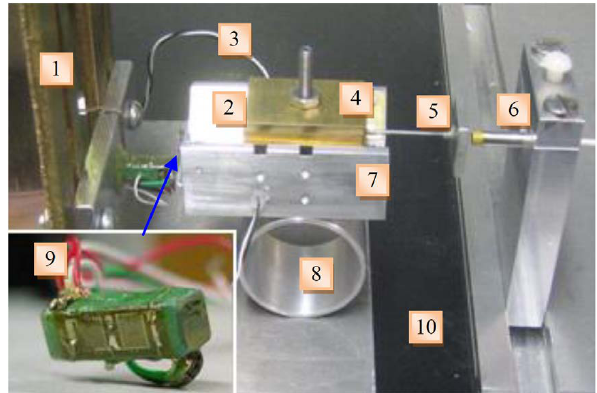
Figure 6. Experimental system of the PE-SSA (Li et al.,